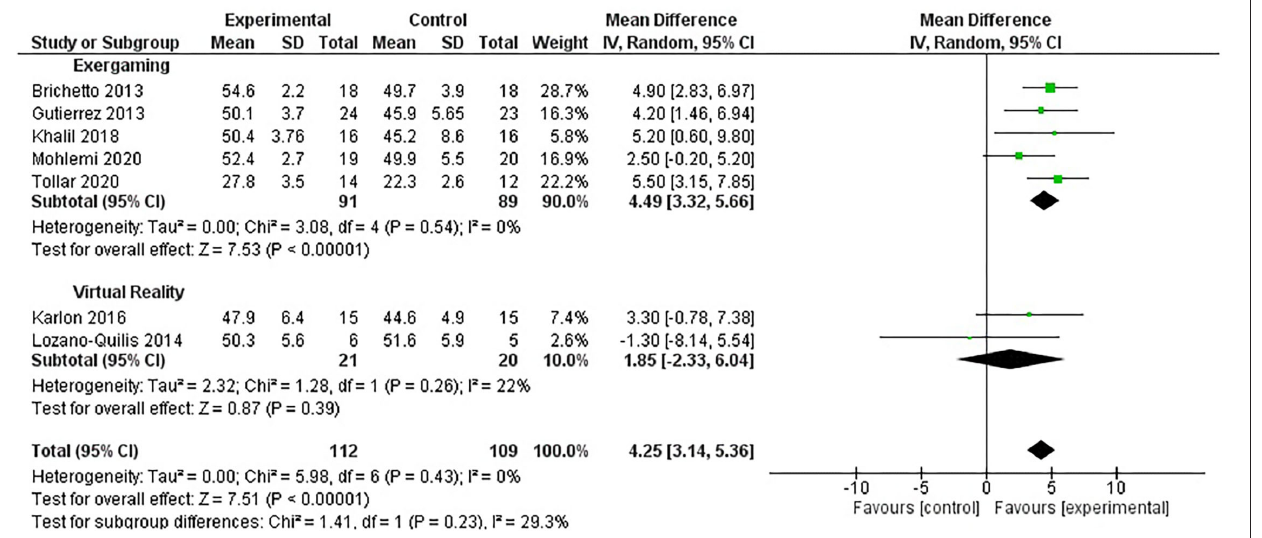
FIGURE 2 | Forest plot illustrating the comparison between exergaming and virtual reality interventions vs. conventional rehabilitation through a meta-analysis.